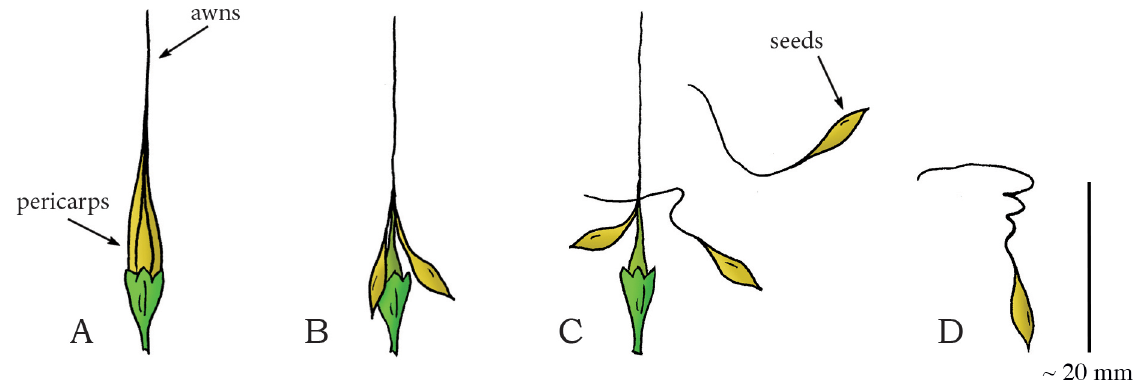
Fig 16. Drying coiling catapult mechanism in the geranium Erodium cicutarium . (A) Fruit consisting of five interconnected pericarps with long awns. (B) Dehydration of the awns creates tension in the awns, as the preferred dry shape of the awns is helical, resulting in dehiscence. (C) When a critical stress is reached, complete dehiscence of the connection between the awns discharges the seeds. (D) A discharged dry seed with awn. Drawings based on a photograph in [82]. Scale bar 20 mm.